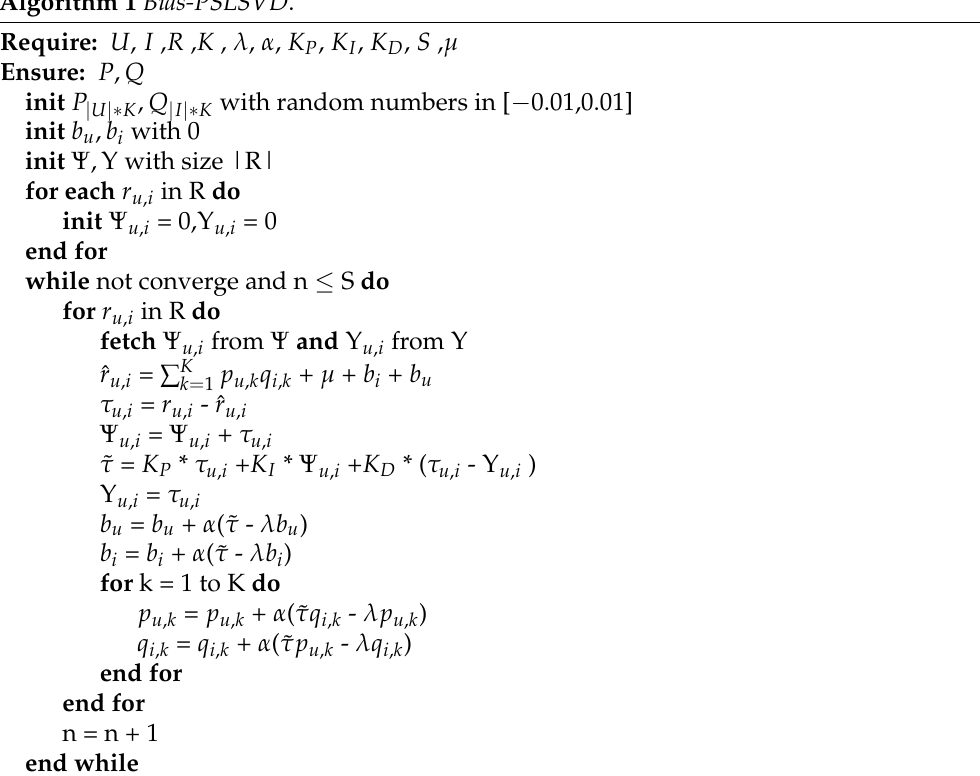
Algorithm 1 Bias-PSLSVD